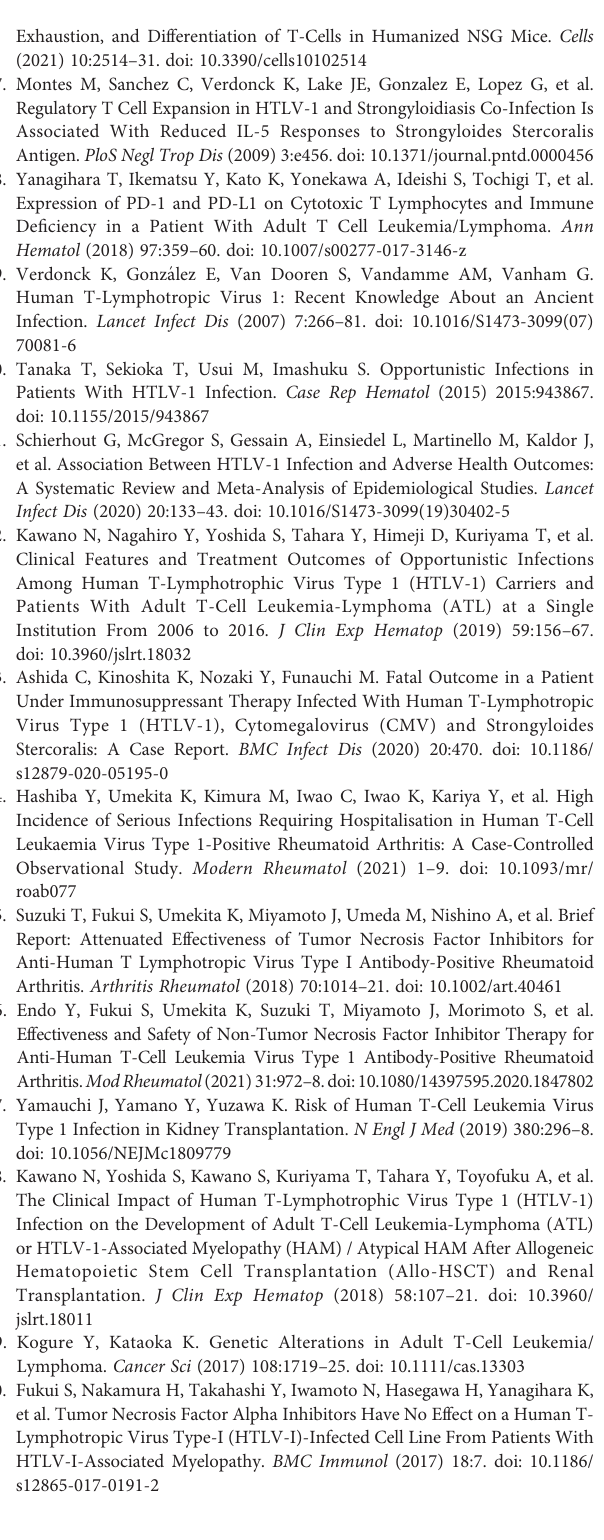
Supplementary Figure 1 | TimecourseofHTLV-1PVLover2yearsinthepatients whostartednewb/tsDMARDs.The D valueofHTLV-1PVLfromatafterstartingnewb/